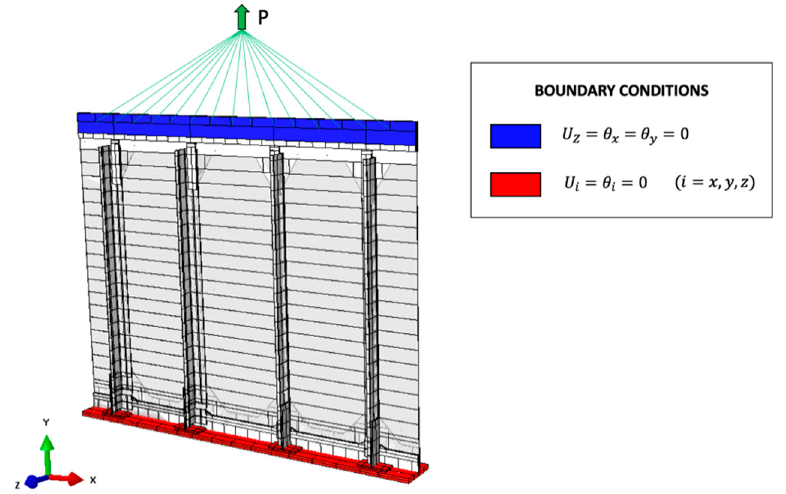
Figure 7. Model for the high-fidelity direct FEM.